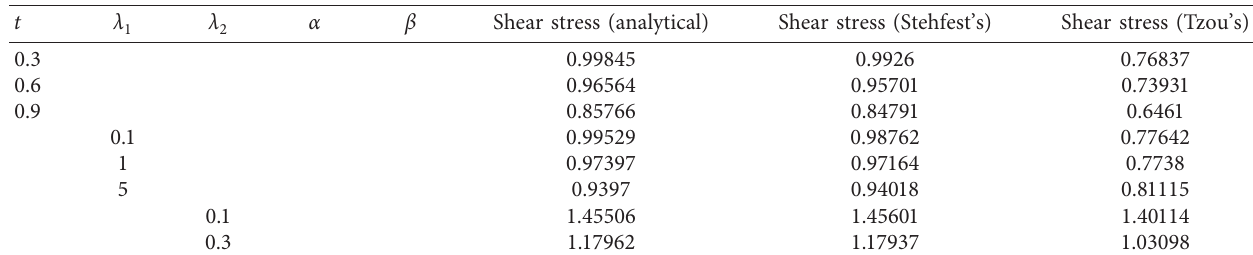
Table 5: Comparison of analytical and numerical solution for shear stresses of cos